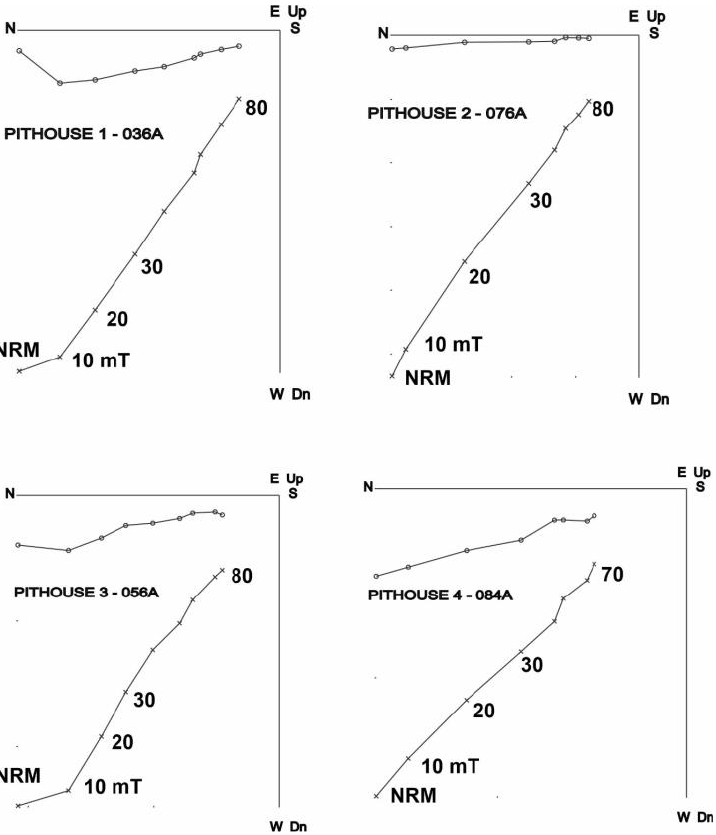
Figure 5. Representative orthogonal diagrams of alternating field treatments for La Playa representative samples.